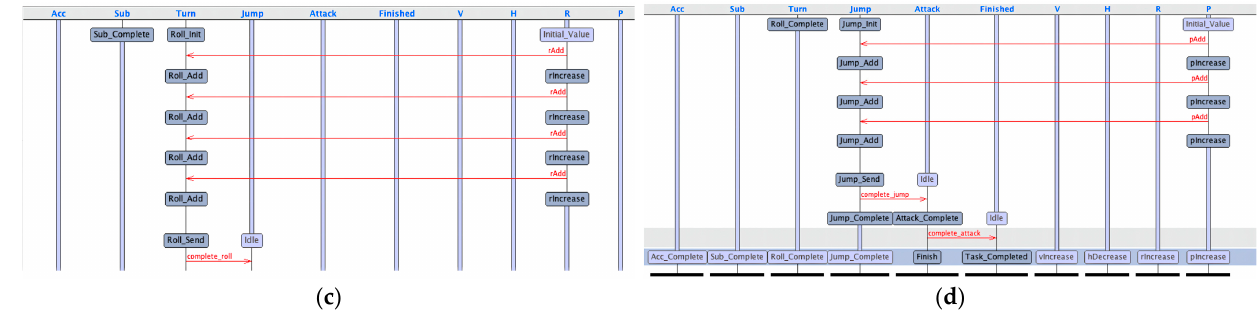
Figure 5. Flowchart of the attack mission. ( a ) Flowchart of Acc_Action. ( b ) Flowchart of Sub_Action. ( c ) Flowchart of Turn_Action. ( d ) Flowchart of Jump_Action, Attack_Action and Finished_Action. Based on the timed automata template, the key attributes in the process of the hetero- geneous UAV cluster attack mission were verified with the help of an UPPAAL